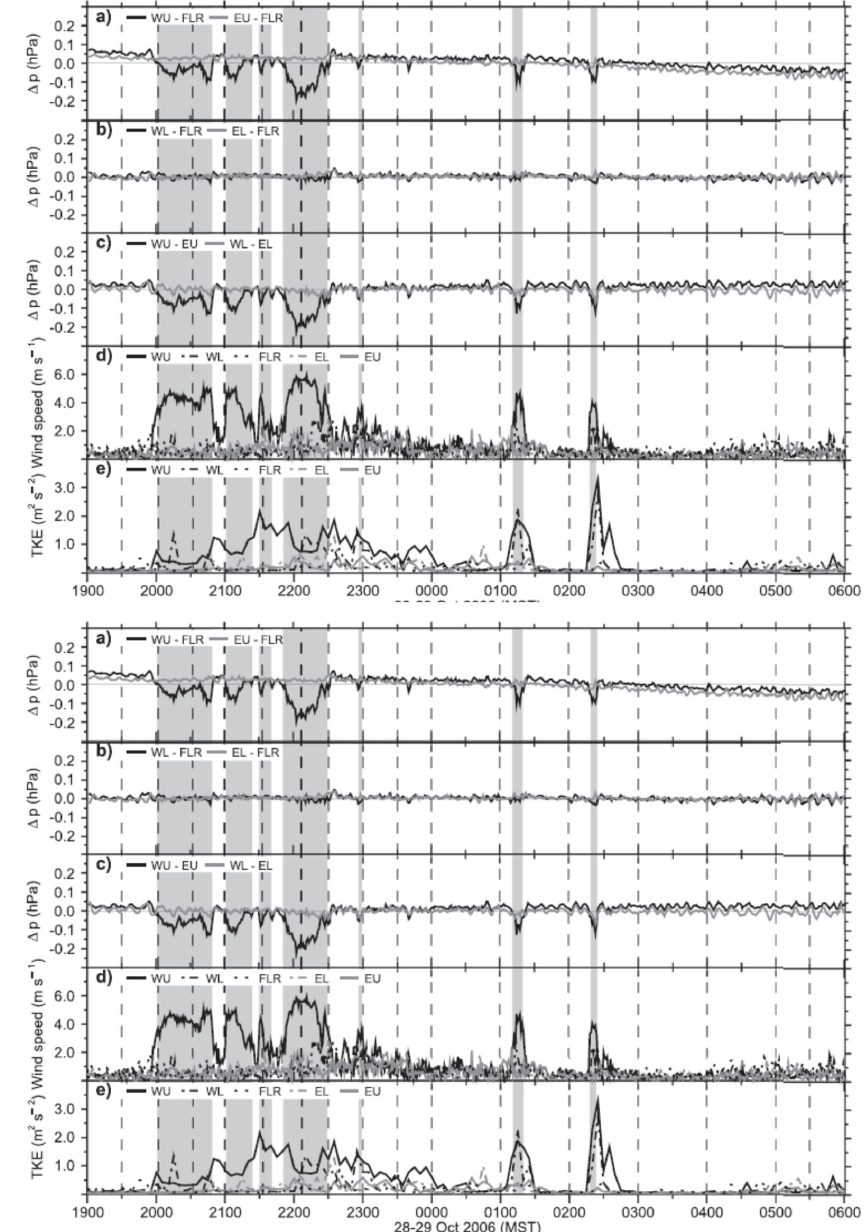
Figure 2. Time series of the 1-min-average ( a ) pressure difference ∆ p between crater’s western upper sidewall (WU) and crater floor (FLR) and between crater’s eastern upper sidewall (EU) and FLR, ( b ) ∆ p between crater’s western lower sidewall (WL) and FLR and between crater’s lower sidewall (EL) and FLR, ( c ) ∆ p between WU and EU and between WL and EL and ( d ) terrain-following wind speed and ( e ) 5-min-averge turbulent kinetic energy (TKE) at 5 m above ground on 28/29 October. The grey dashed vertical lines mark the launch times of tethersondes soundings, the black dashed vertical lines indicate soundings with warm-air intrusions, and the grey-dashed areas indicate times with warm-air intrusion as determined from pressure and wind measurements (from [77], ©American Meteorological Society. Used with permission).